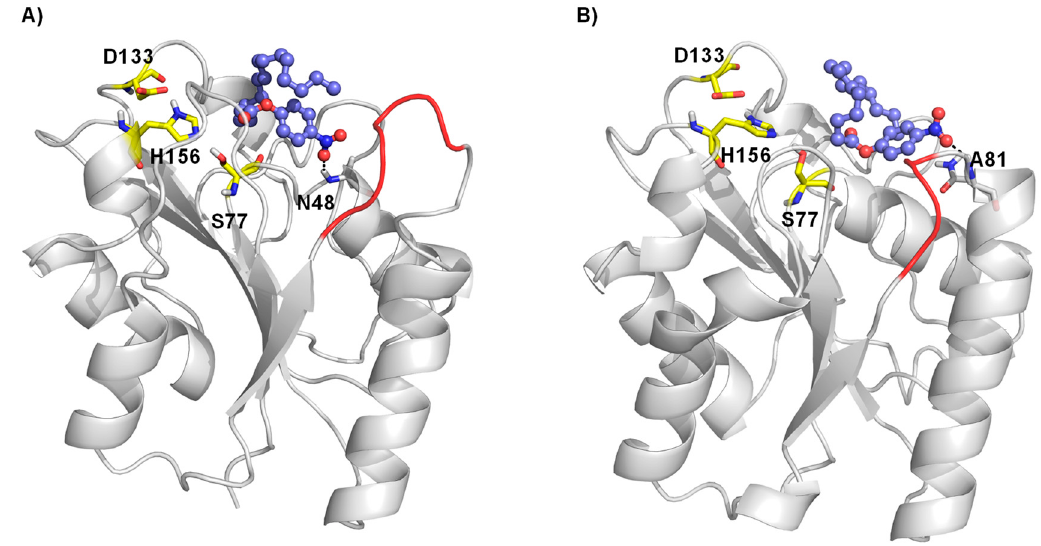
Figure 7. Molecular docking of palmitate substrate in the binding pocket of BSLA WT ( A ) and BSLA P5F3 variant (F41L- ∆ W42- ∆ D43-K44P) ( B ). Substrate p -nitrophenyl palmitate is shown as ball and stick, whereas the catalytic triad (S77, D133 and H156) is shown as yellow sticks. The hydrogen bond interactions are shown with a black dotted line and region 3 is highlighted in red.